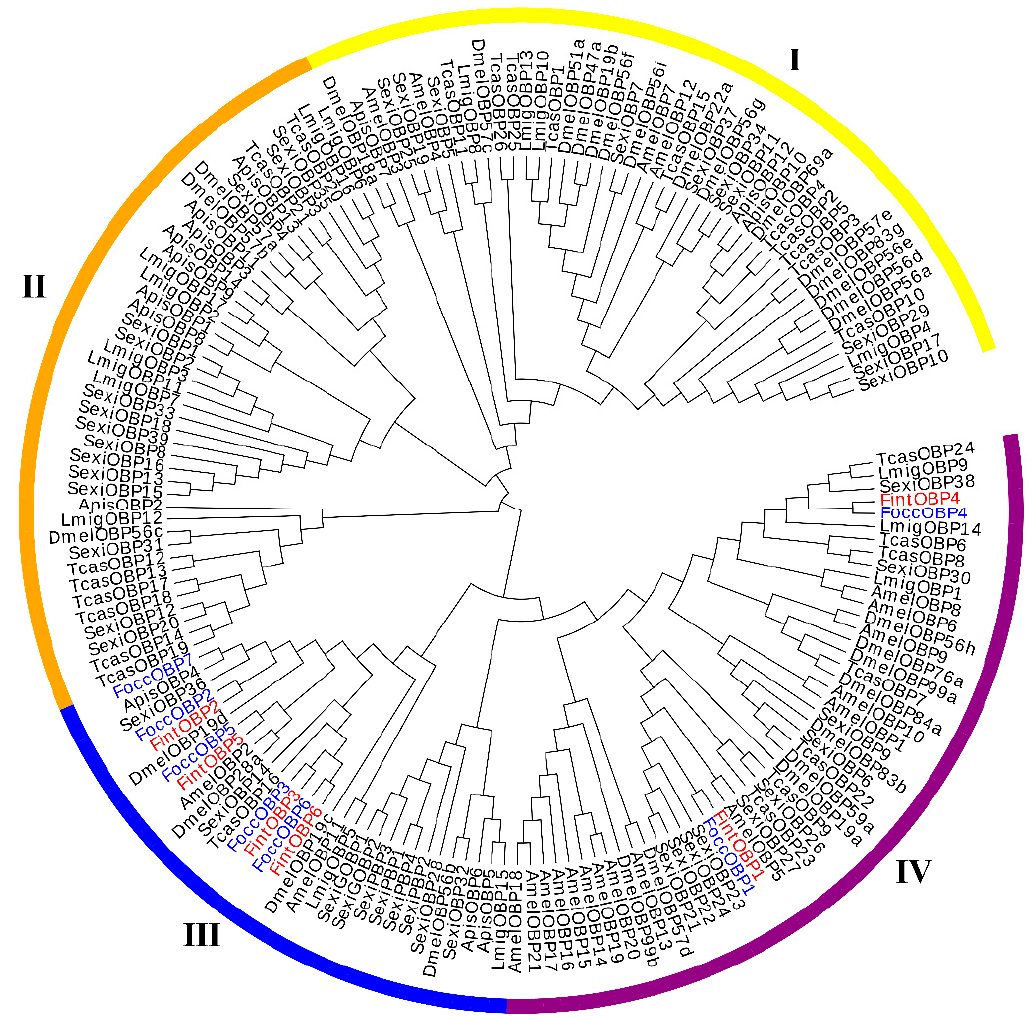
Figure 4. Maximum likelihood tree of OBPs from two Frankliniella species and representative species from six other insect orders. Species abbreviations are: Focc, Frankliniella occidentalis (Thysanoptera); Fint, Frankliniella intonsa (Thysanoptera); Apis, Acyrthosiphon pisum (Hemiptera); Amel, Apis mellif- era (Hymenoptera); Dmel, Drosophila melanogaster (Diptera); Lmig, Locusta migratoria (Orthoptera); Sexi, Spodoptera exigua (Lepidoptera); Tcas, Tribolium castaneum (Coleoptera). Four sub-groups have been identified on the tree: I, Sub-group I; II, Sub-group II; III, Sub-group III; IV, Sub-group IV.